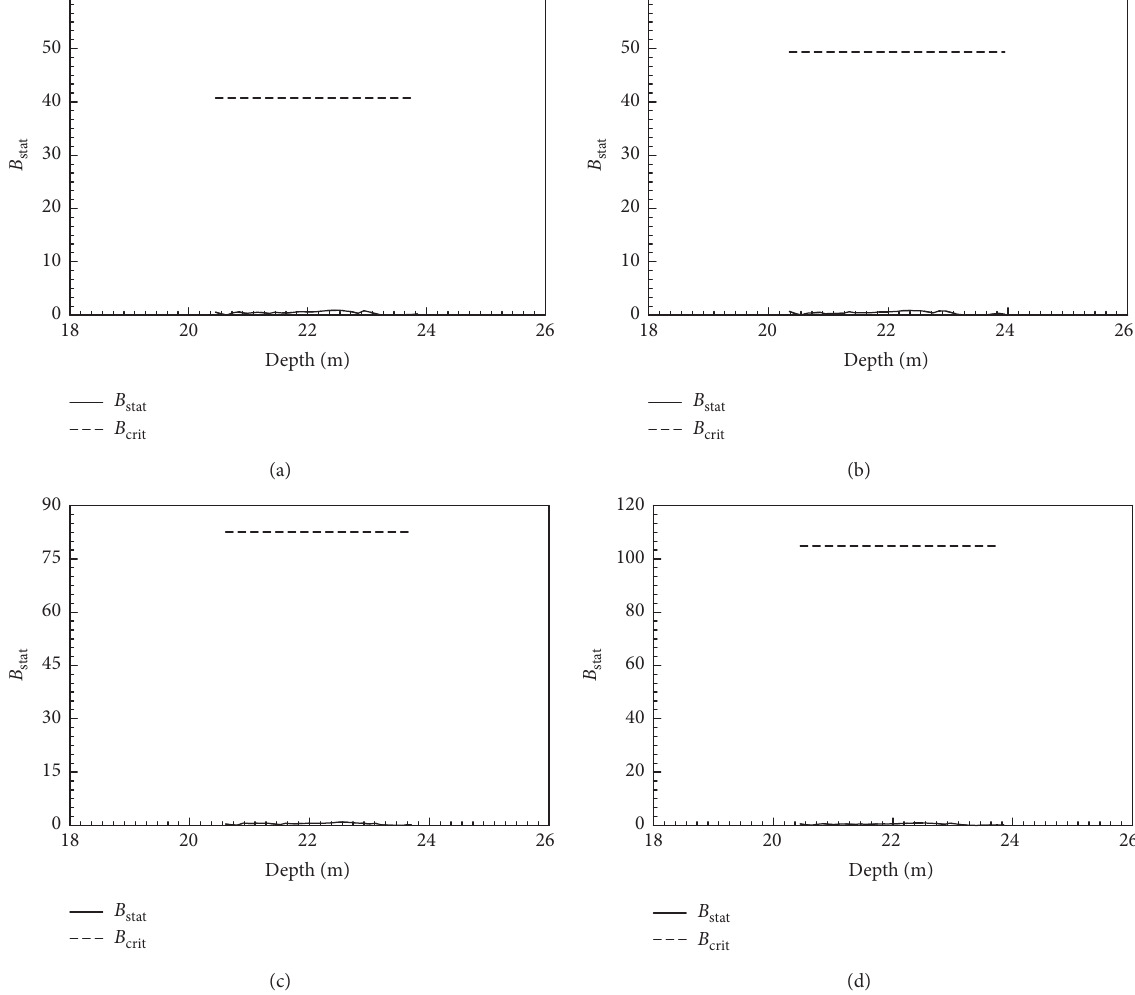
1 . (b) M 2 . (c) M 3 . (d) M 4